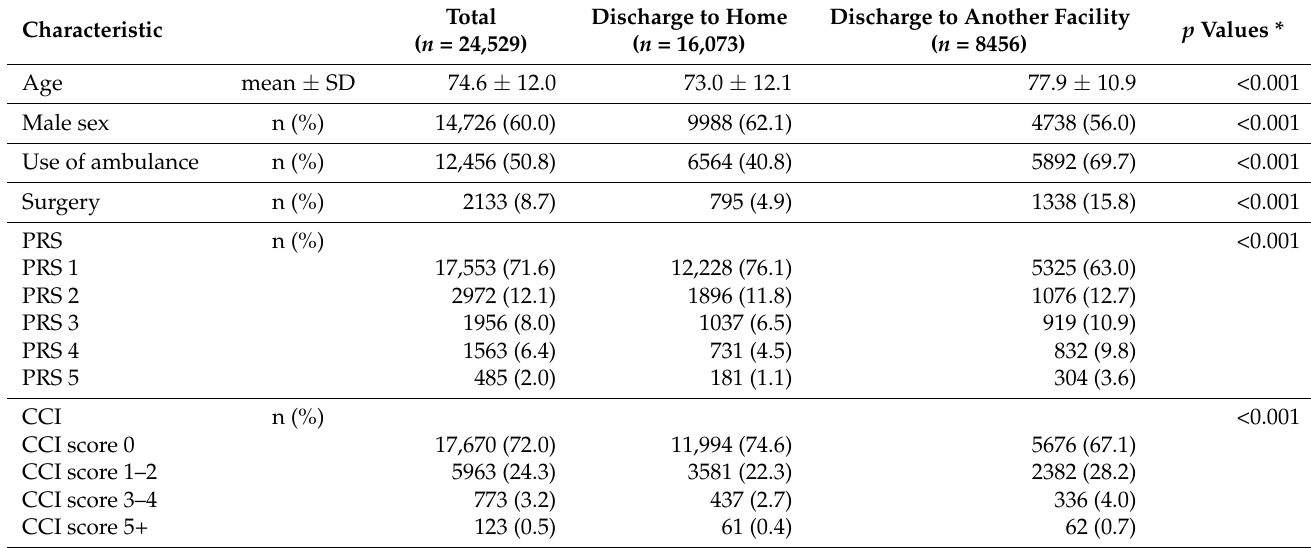
Table 1. Demographic characteristics of patients in five-year HSHR